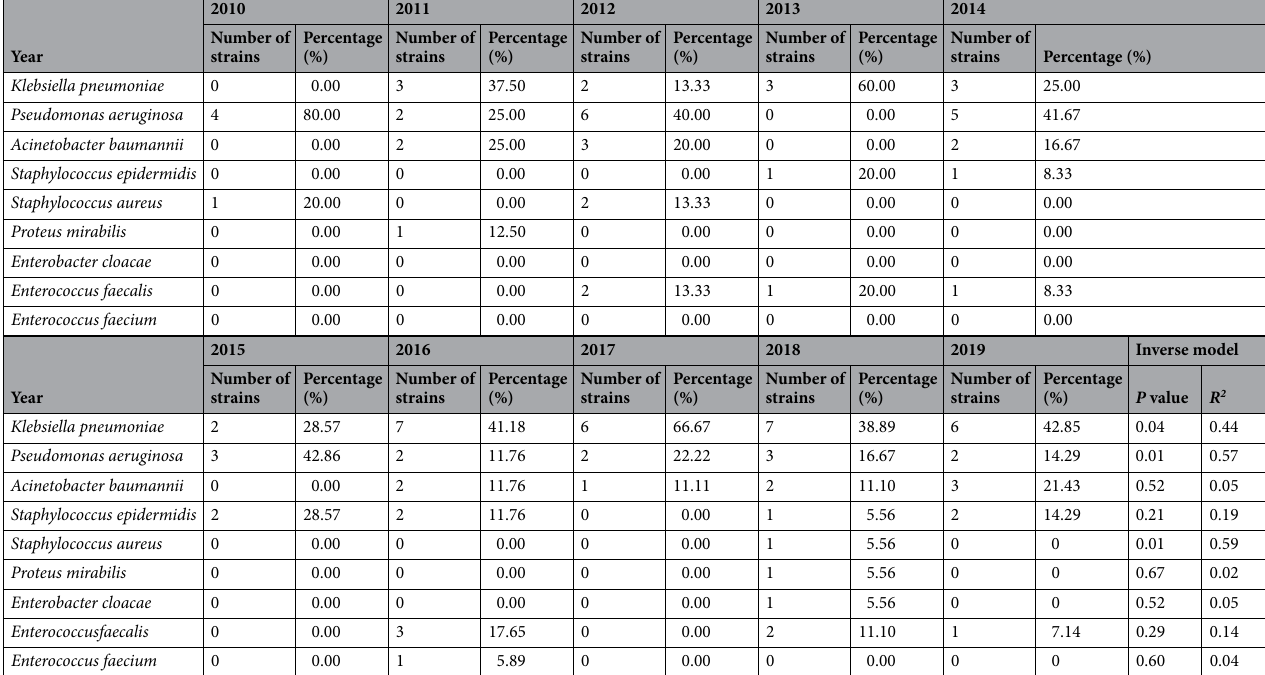
Table 2. Annual changes in the bacterial composition ratios detected in the blood cultures of burn patients.